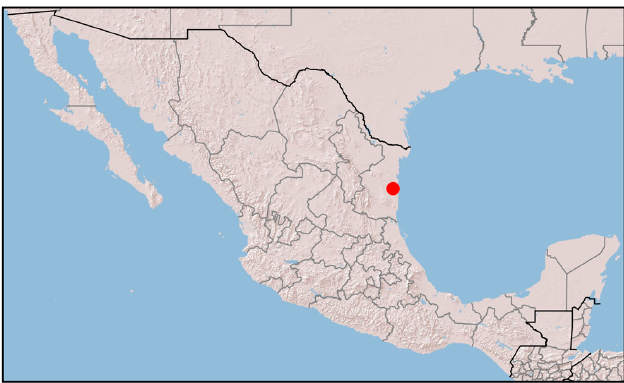
Figure 2. Location of the anemometric mast installed in the municipality of Soto la Marina in the state of Tamaulipas,